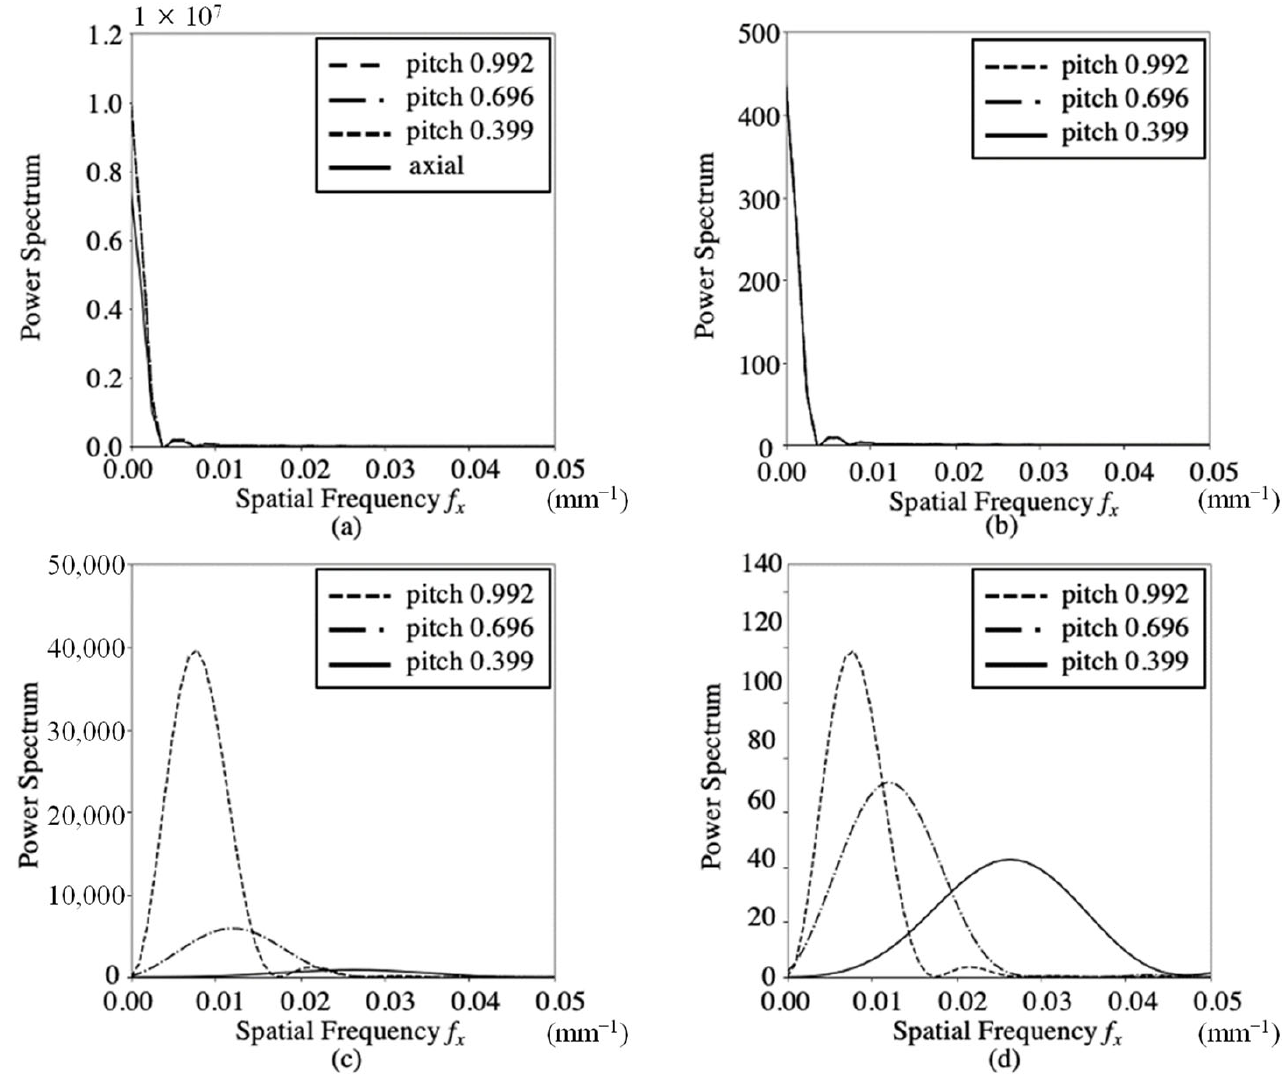
Figure 5. 2D and 3D spectra of Noise BL ( x , y ) and Noise VA ( x , y , z ) in FBP images for axial and helical scans. ( a ) 2D spectra of Noise BL ( x , y ) on the f x axis, ( b ) 2D normalized spectra of Noise BL ( x , y ) on the f x axis, ( c ) 3D spectra of Noise VA ( x , y , z ) on the f x axis, and ( d ) 3D normalized spectra of Noise VA ( x , y , z ) on the f x axis.